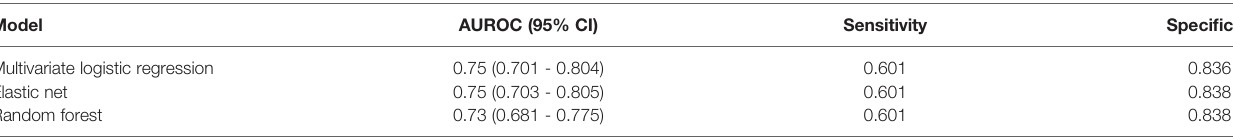
AUROC, area under the receiver-operating curve; CI, con fi dence